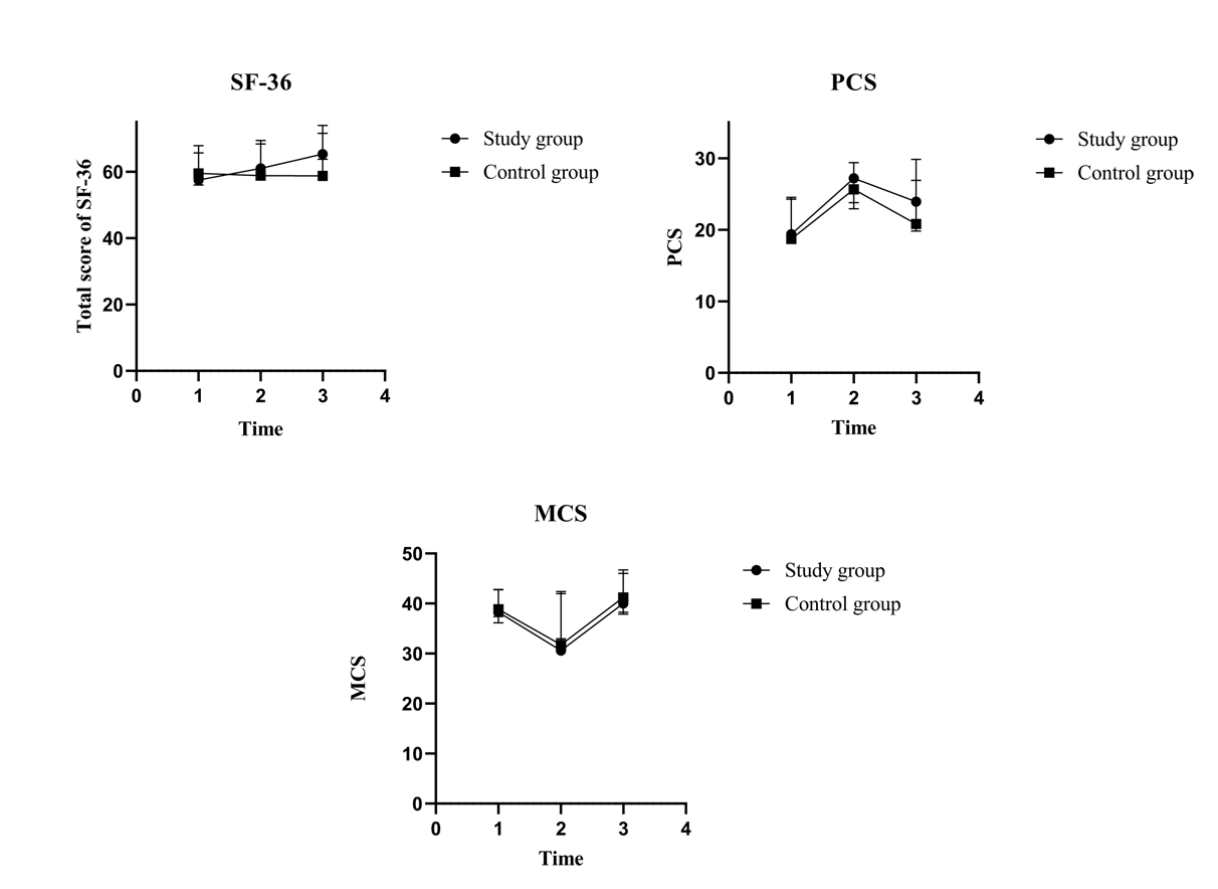
Figure 6. Trend charts of total 36-item Short-Form Health Survey (SF-36) scores and scores of two components. MCS: mental component summary; PCS: physical component summary; time 1: prior to discharge (baseline); time 2: at 12 weeks following discharge; time 3: at 24 weeks following